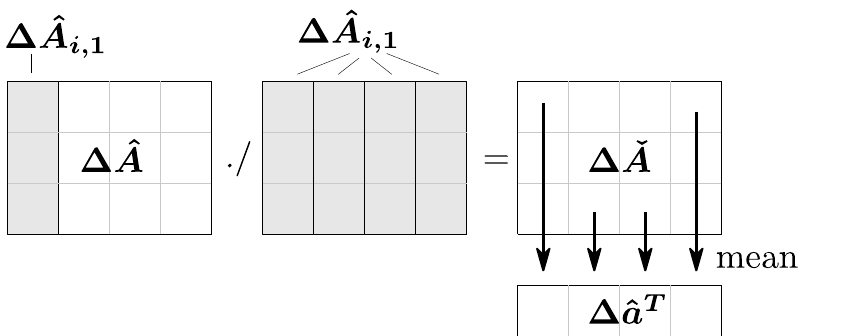
Figure 3. Normalization and averaging used to obtain estimated offsets of transmit steering vector 𝒂 .